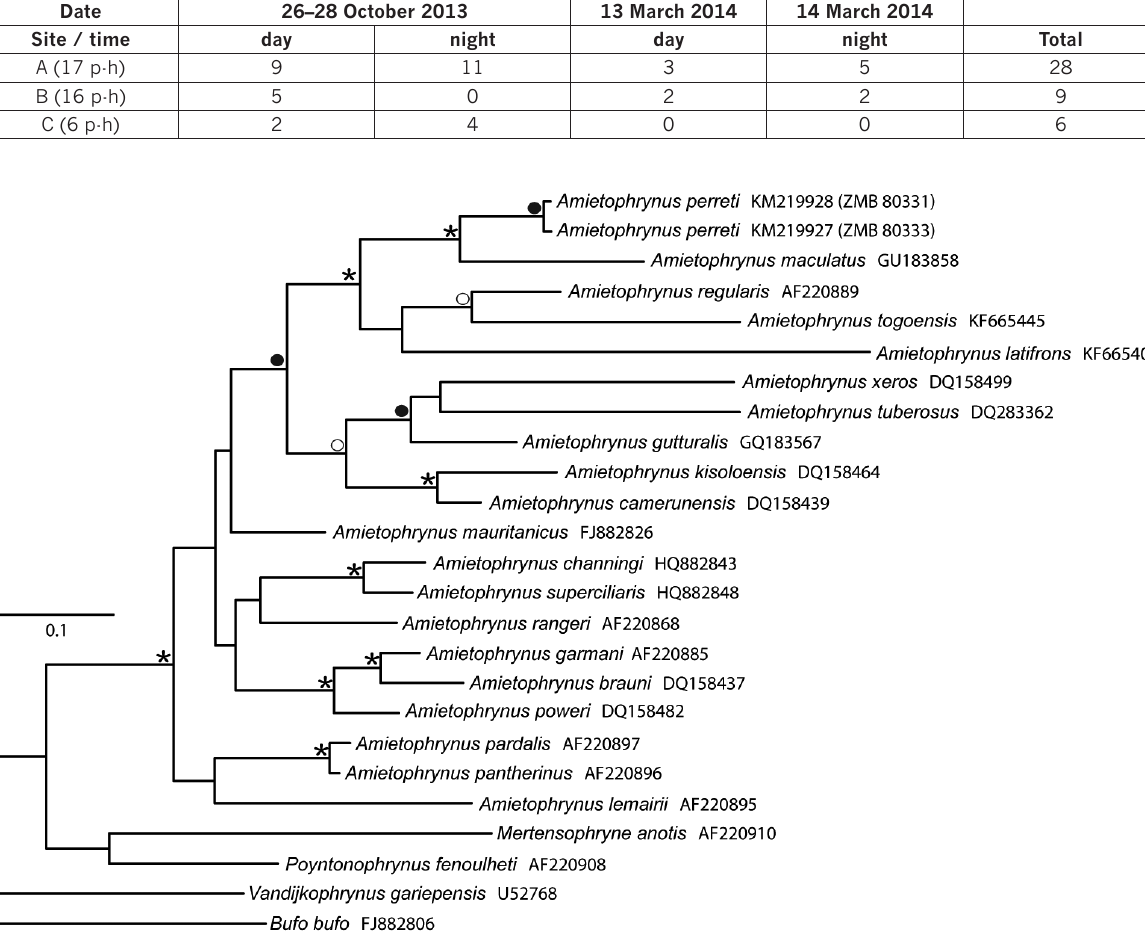
Figure 5. Systematic placement (Bayesian phylogenetic inference based on a mitochondrial fragment of the 16S rRNA gene) of Amietophrynus perreti within the genus Amietophrynus . Bayesian PP values are as follows: asterisks (‘*’) point to maximum support (1.00), full circles (‘●’) point to PP 0.95–0.99; empty circle (‘○’) point to PP 0.90–0.94; PP values below 0.90 not